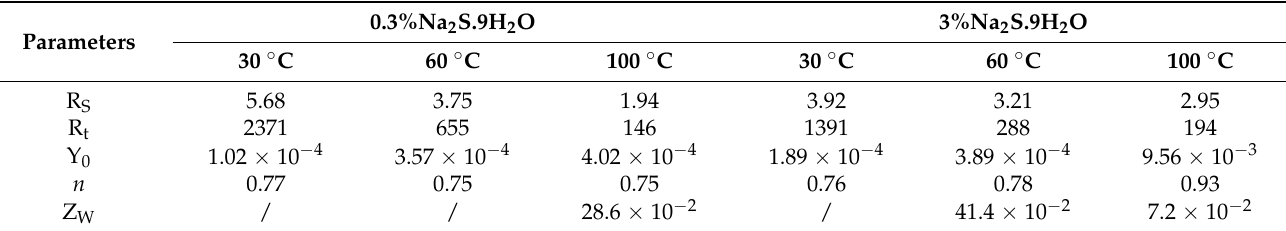
Table 8. AC impedance spectrum fitting parameters for 80S